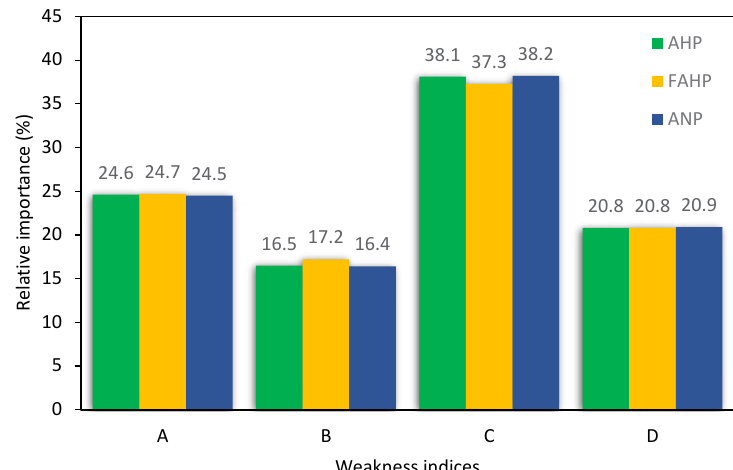
Fig. 3: Comparison of relative importance (weights) of first-level weakness indices using AHP, FAHP, and ANP approaches